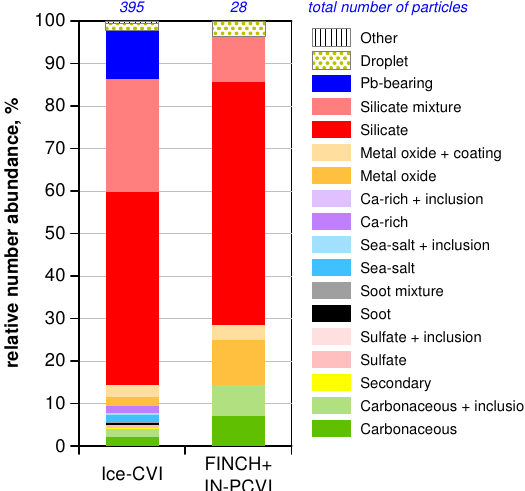
Figure 5. Relative number abundance of different particle groups among INP/IPR for 2 February determined by FINCH + IN-PCVI and Ice-CVI. The total number of analyzed particles is shown above the bars. For confidence intervals see Table S4 in the Supplement.